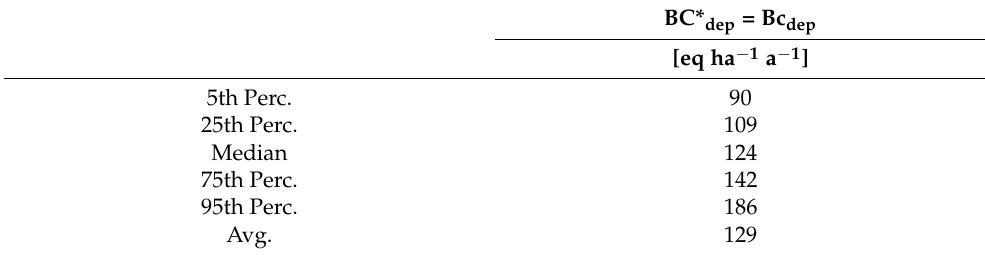
Table 17. Statistical distribution of the sea salt-corrected deposition rate of base cations (BC* dep